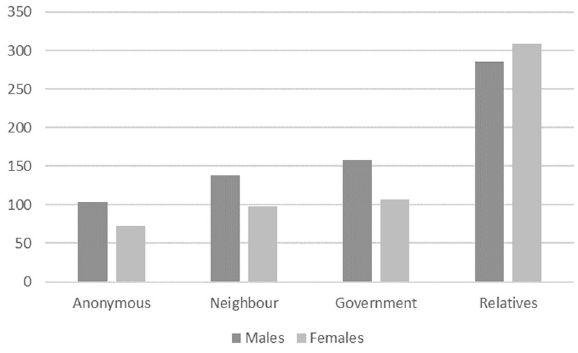
Fig. 5 Average donations by gender, for each dictator game type. Mean donations by female and male for each of the four dictator game